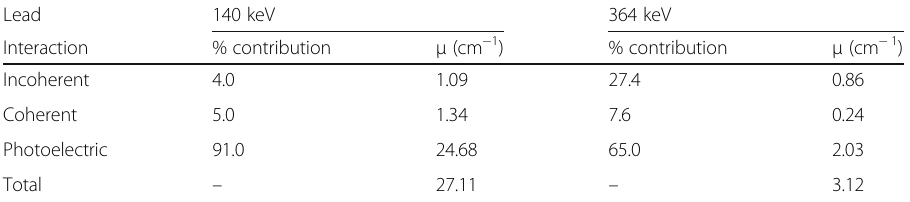
Table 4 Theoretical linear attenuation coefficients of lead at photopeak energies of Tc99m and I131 organised by interaction Lead 140 keV 364 keV Interaction % contribution μ (cm − 1 ) Incoherent